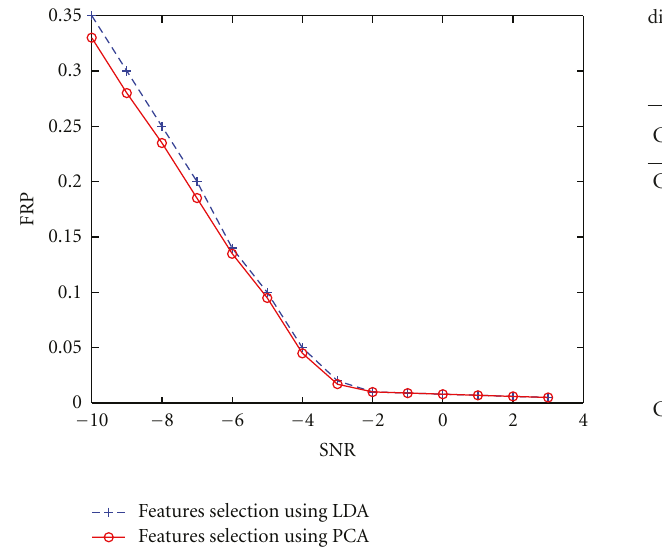
Figure 11: Performance comparison between PCA and LDA features selection algorithm (False Recognition Probability versus SNR for Inter-class recognition case II).